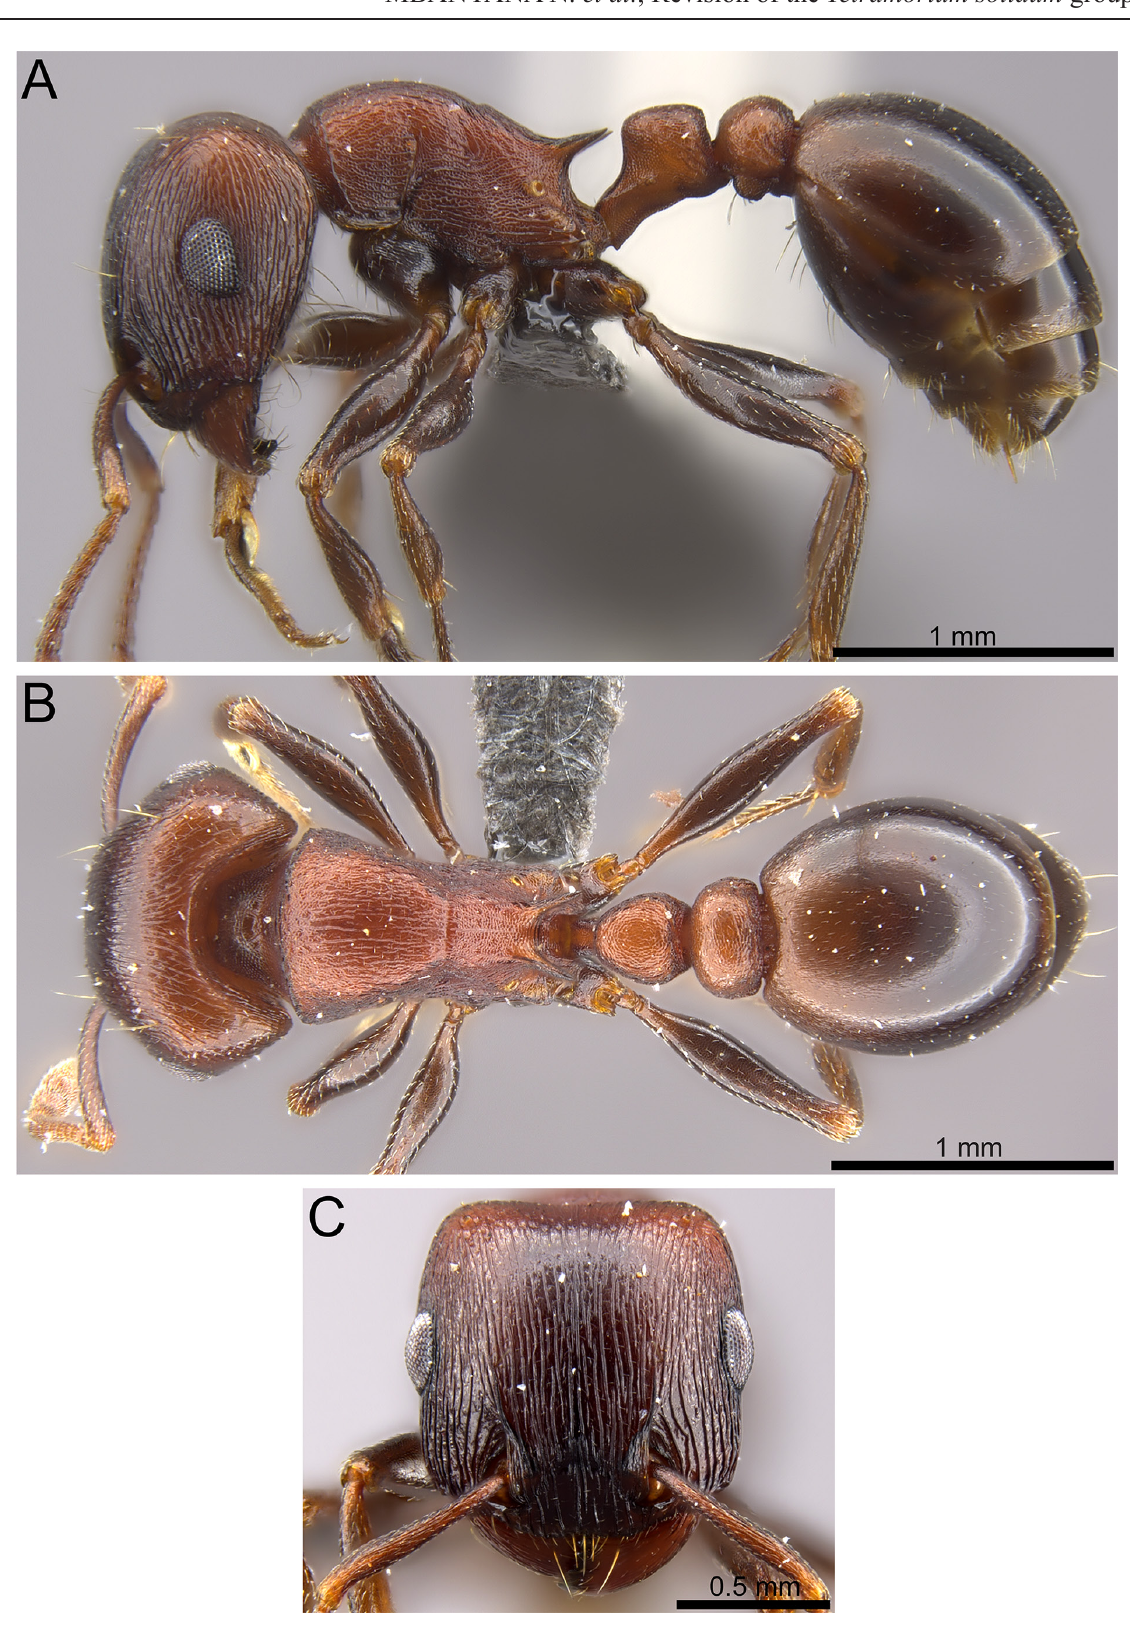
Fig. 20. Tetramorium rufescens Stitz, 1923 (CASENT0250852). A . Body in profile. B . Body in dorsal view. C . Head in full-face